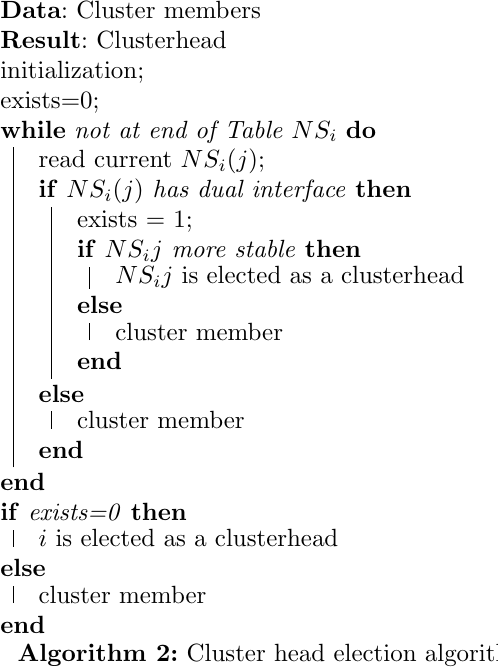
Algorithm 2: Cluster head election algorithm